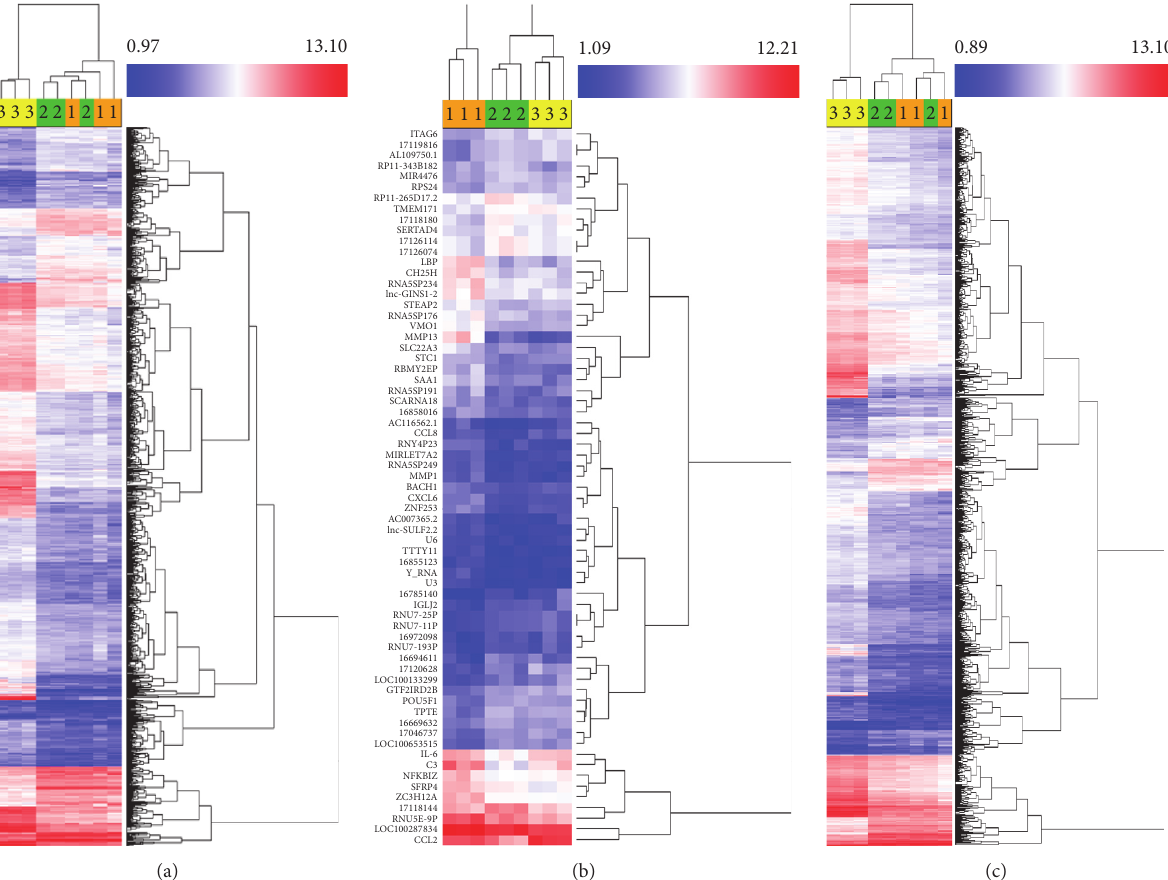
Figure 3: Gene expression profile of MSC-17 (1), UT-MSC (2), and MSC- 𝛾 (3) from 3 MSC donors determined with Affymetrix Human Gene ST 2.0 microarrays. Supervised hierarchical clustering of genes differentially expressed between (a) MSC- 𝛾 versus UT-MSC, (b) MSC- 17 versus UT-MSC, and (c) MSC-17 versus MSC- 𝛾 determined by ANOVA 𝑝 value (condition pair) 𝑝 < 0.05 and fold change (linear) < − 2 or > 2. (a) 1278 and (b) 67 genes were differentially regulated between the treatment groups. The normalized expression value for each gene is visualised by a colour gradient: blue represents low gene expression; red represents high gene